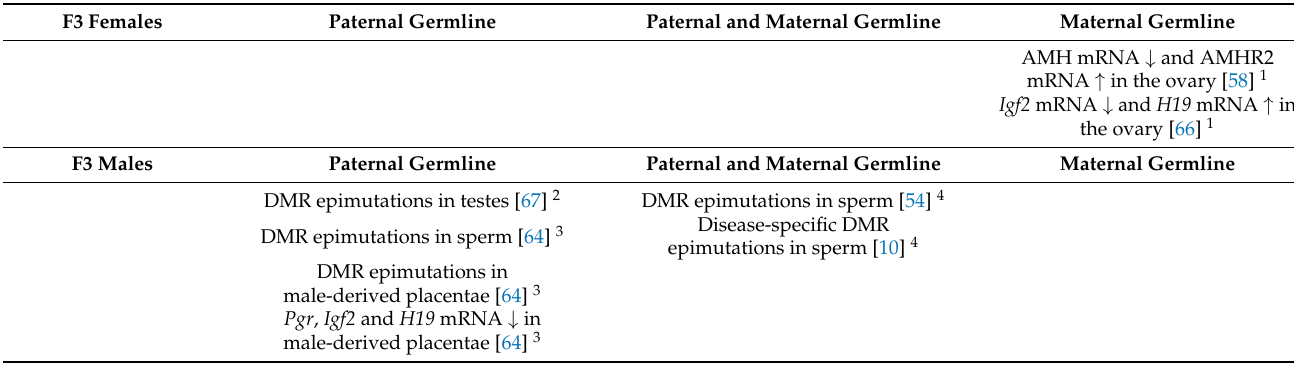
Table 2. Epigenetic mechanisms involved in TCDD transgenerational effects on female and male reproductive health in rodent